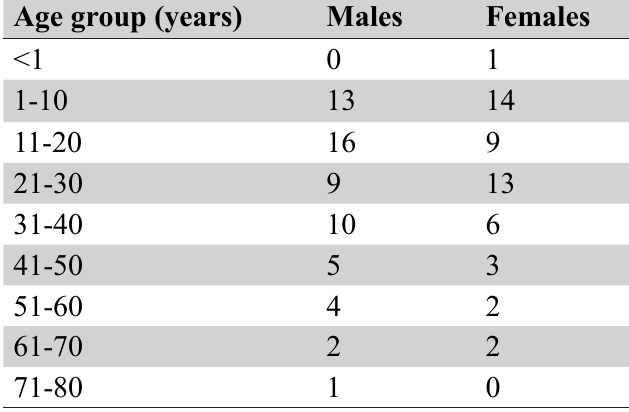
Table 1. Age and sex distribution of the study population.